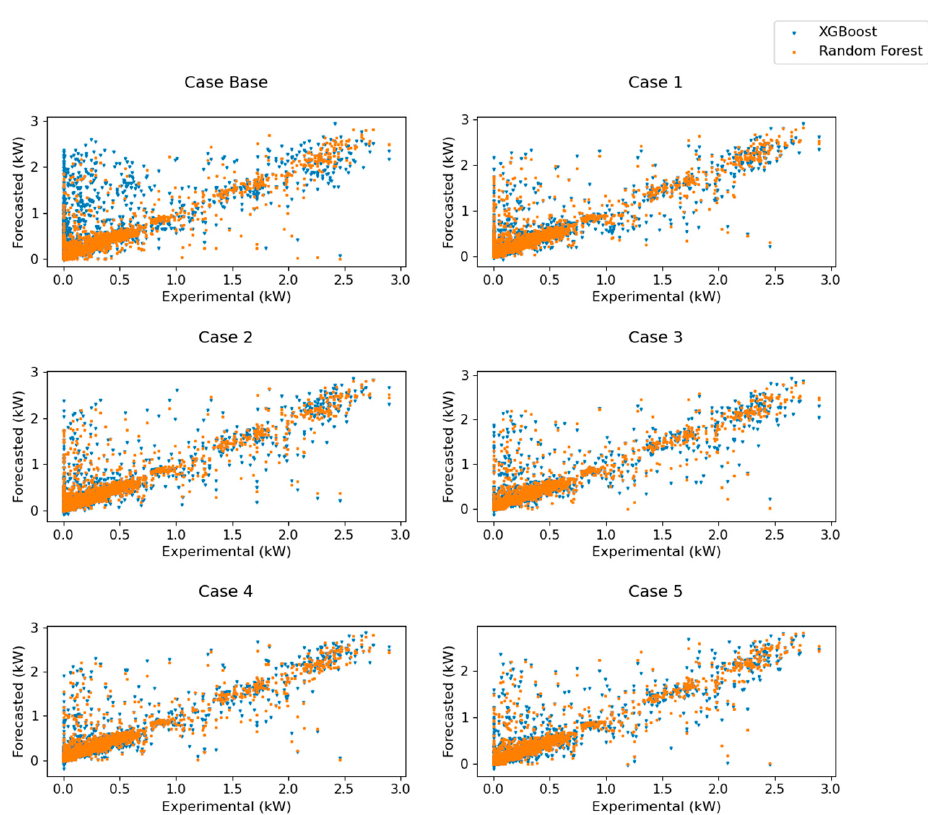
Figure 4. Scatter plot of forecasted power for south array.